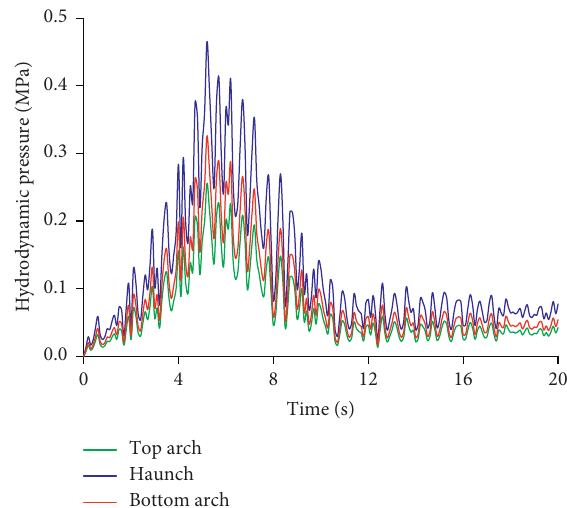
Figure 5: Hydrodynamic pressure time-history of monitoring